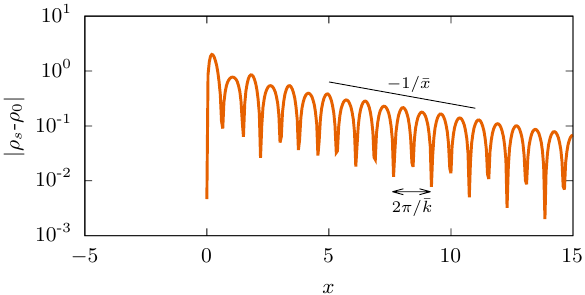
Figure 4. Characterization of stationary profiles. Long-time solutions approach a stationary state characterized x . The slope of the straight black line is indicated in the figure. This by the wavelength 2 π/ ¯ k and decay length ¯ example was obtained from numerical integration of Eq. (3), assuming a semi-infinite habitat, with parameters 0.003 , γ 2 and q 0.5 D q ( x ) with ℓ = = = −